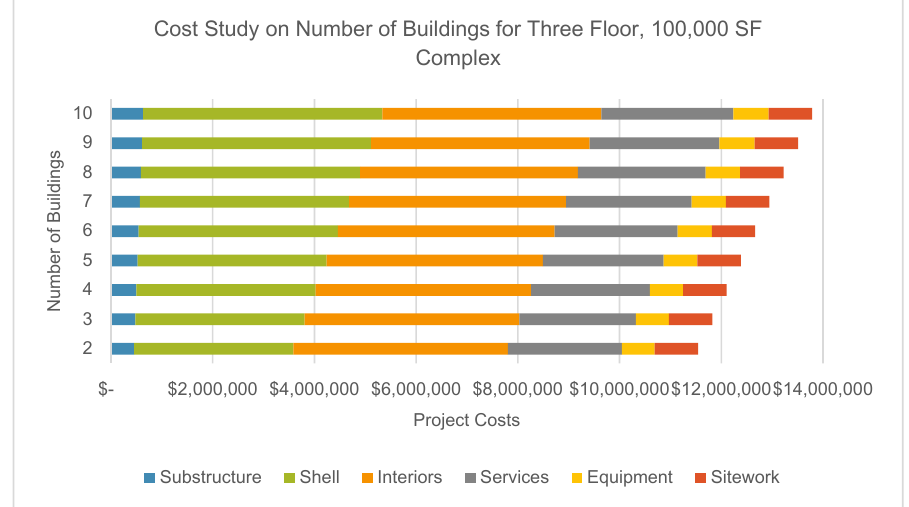
Figure 5. Study of Cost by Number of Buildings with Height and Width Constant.